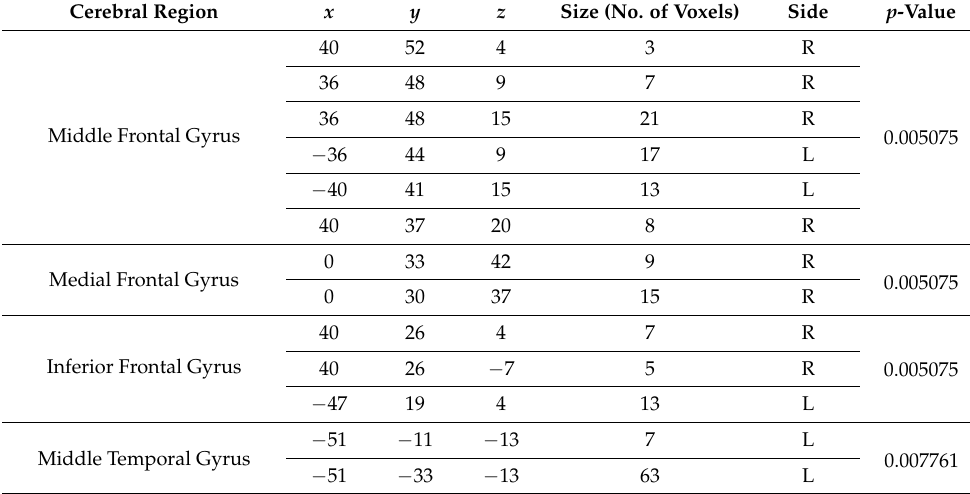
Table 5. Regions of brain activation (Talairach coordinates) showing significantly greater correlation with the number of A alleles of the AKT1 rs1130233 polymorphism under THC condition than under placebo condition while viewing fearful faces after controlling for percentage methylation at CpG island 11–12 around rs1130233 polymorphism in the AKT1 gene. L and R indicate the left and right